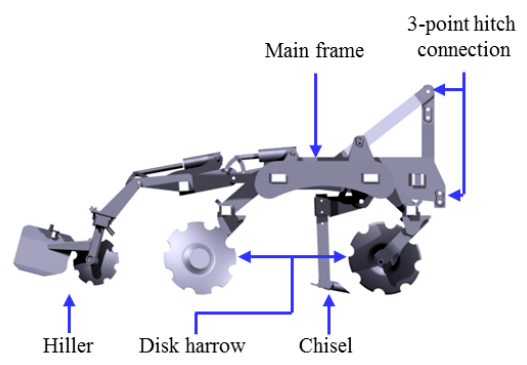
Figure 1. Structure of composite working implements.